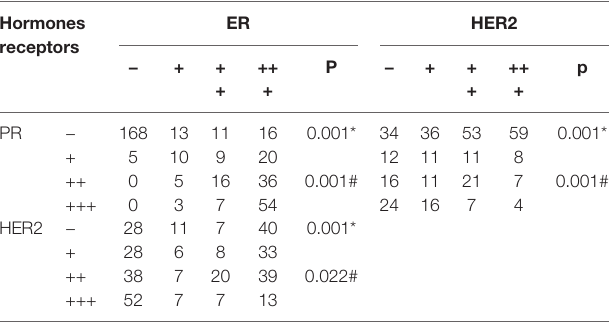
TABLE 5 | Association between any two hormones